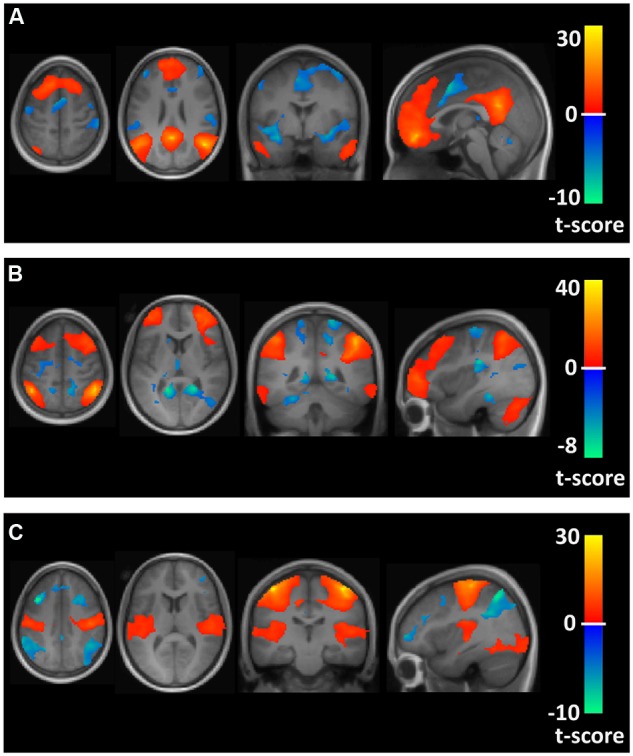
Axial, coronal, and sagittal views of spatial maps for each resting state network (orange) and the corresponding anti-correlations (blue) for the conjunction of the seed region maps averaged across all 22 participants.
(A–C) Show the default mode network (DMN), frontoparietal network (FPN), and motor network (MN), respectively.